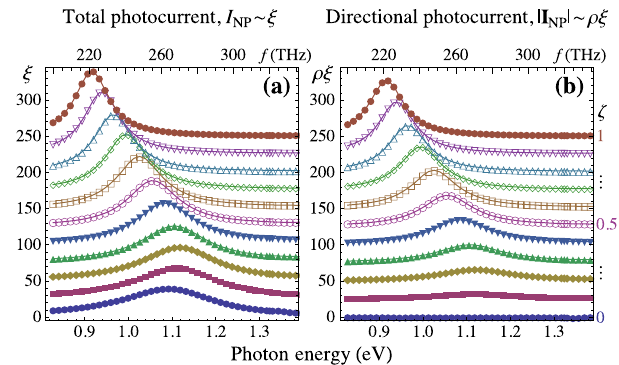
FIG. 3. (a) Total photocurrent I and (b) z component of the NP directional photocurrent I for different values of the conicity NP parameter ζ . The lines are offset by 25 for easier readability.